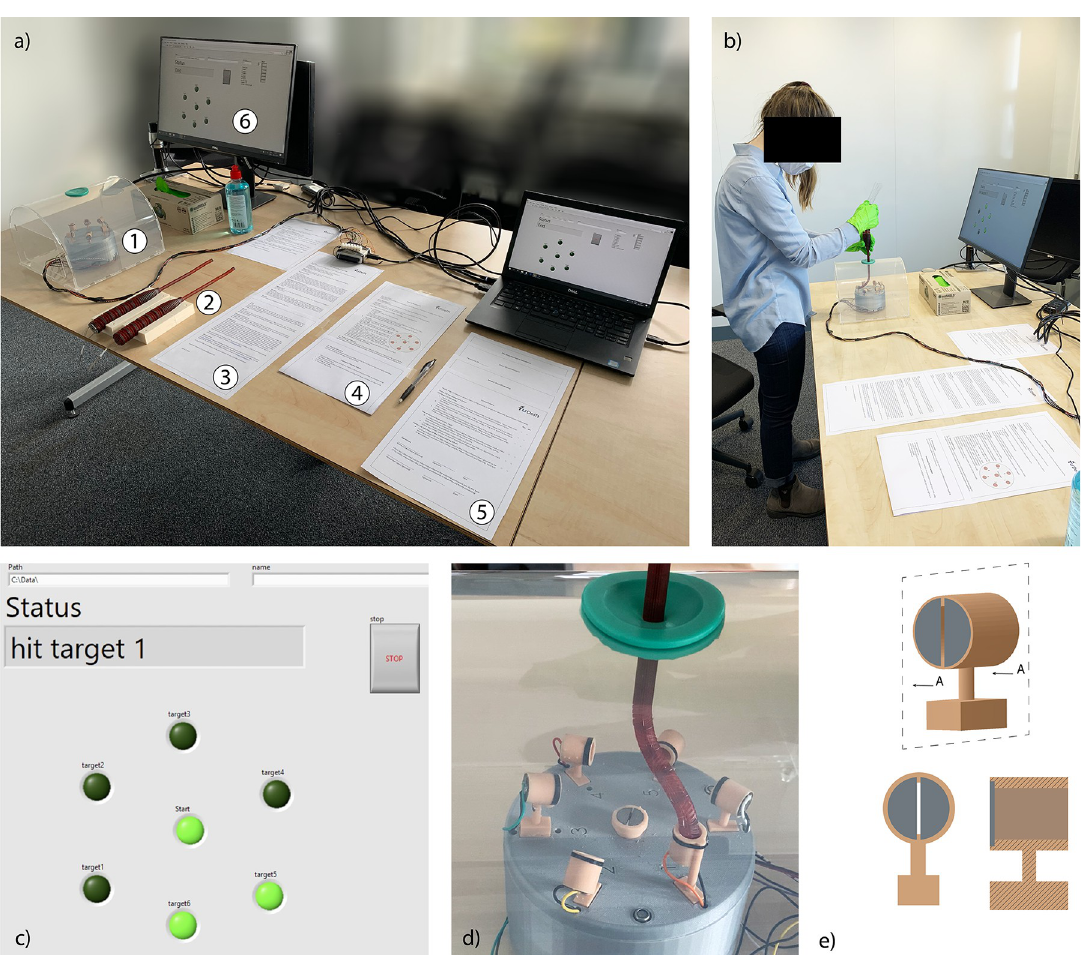
Fig 7. Experimental setup. a) Setup and its components: 1. simulator, 2. instruments, 3. participant information letter, 4. general instruction, 5. informed consent and questionnaires, 6. user interface. b) A participant during the test. c) The user’s interface during the experiment. Each green circle represents a target. The light green circles are the targets already hit, and the dark green circles are the targets still to be hit. The status bar displays the next target that the participant has to hit. d) The instrument into one of the targets. d) A participant during the test. e) CAD model of the target with back view and cross-section. The two steel plates are represented in